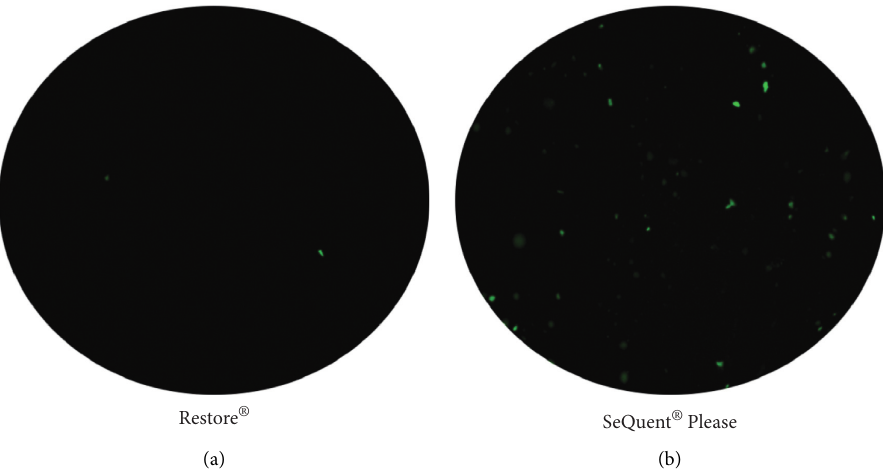
Figure 3: Representative images of particulate formation after balloon inflation. Restore ® balloon (a) had fewer large visible particles compared to the SeQuent ® Please balloon (b).